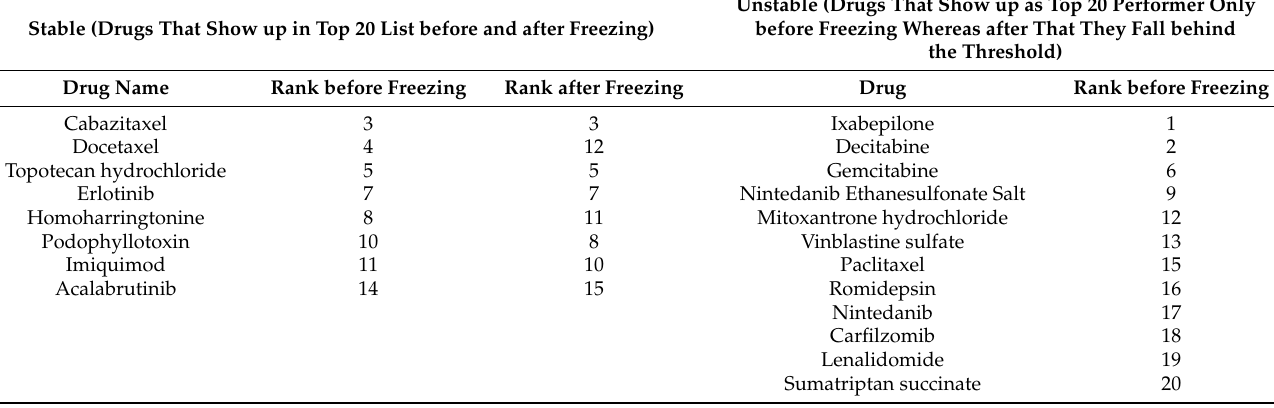
Table 1. The list of stable and unstable drugs for IPS11-wild type. Unstable (Drugs That Show up as Top 20 Performer Only Stable (Drugs That Show up in Top 20 List before and after Freezing) before Freezing Whereas after That They Fall behind the